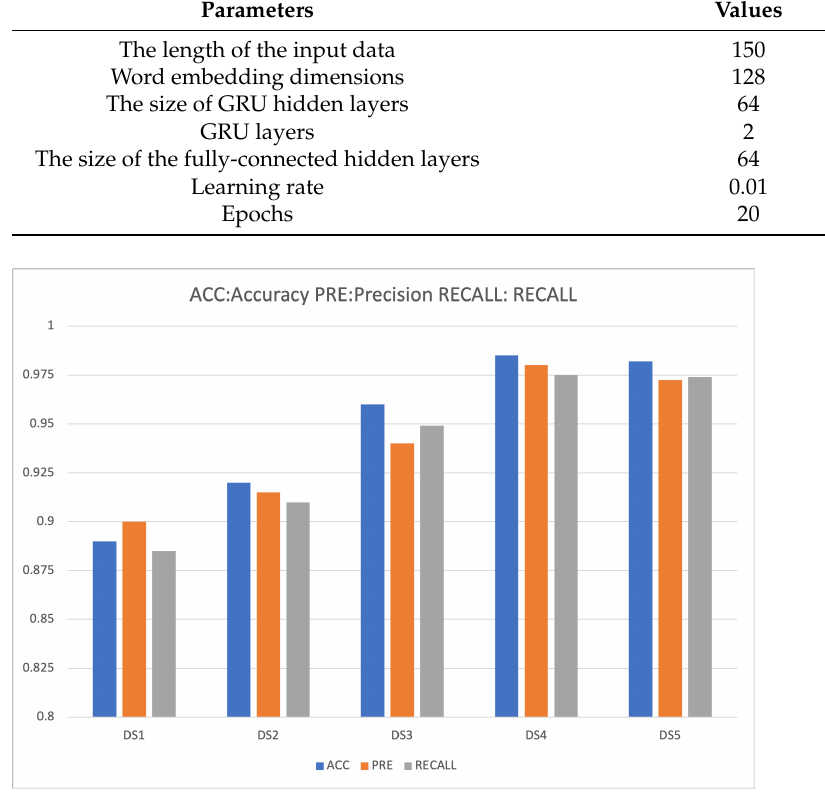
Figure 3. The experimental results of the indicators on different